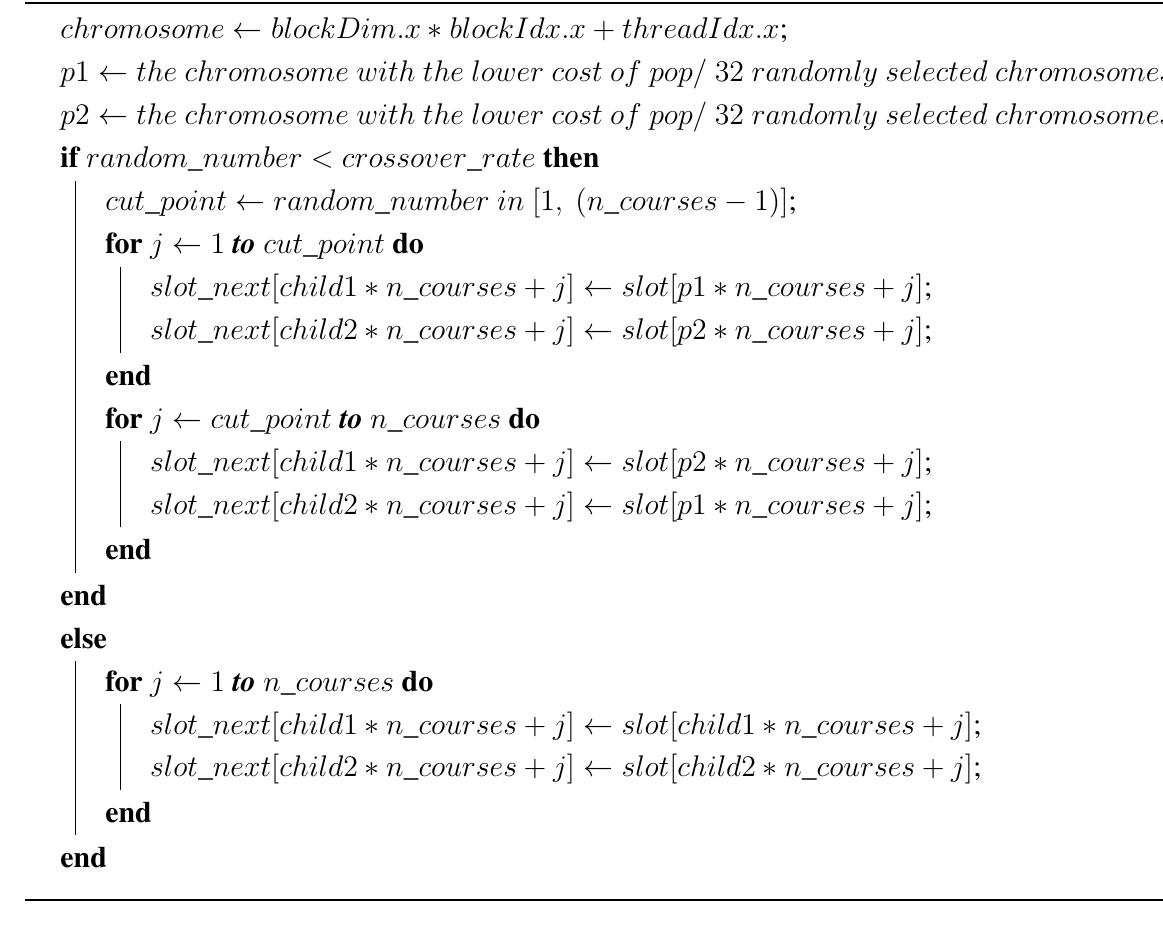
Algorithm 4: Selection and reproduction, chromosome-threaded approach: each thread produces two new